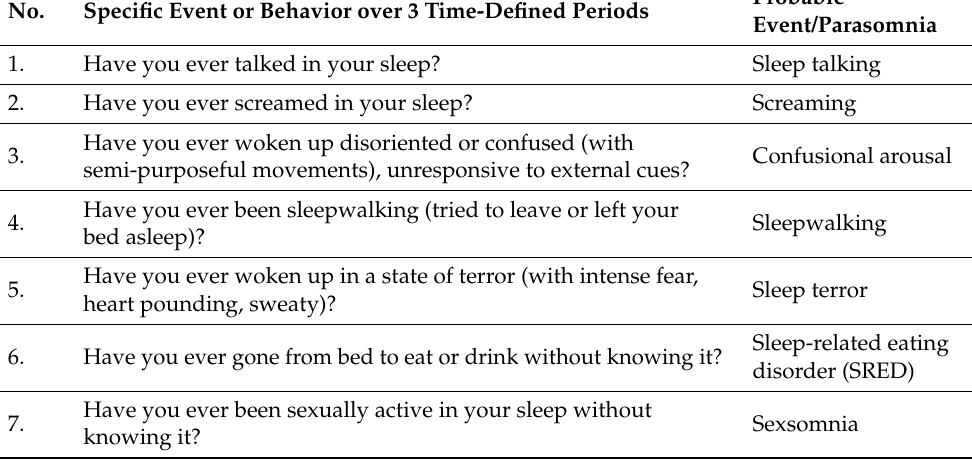
Table 1. The questions asked were related to 3 time-defined periods: (1) within 3 months before pregnancy; (2) during pregnancy; and (3) within 3 months after delivery; and the corresponding